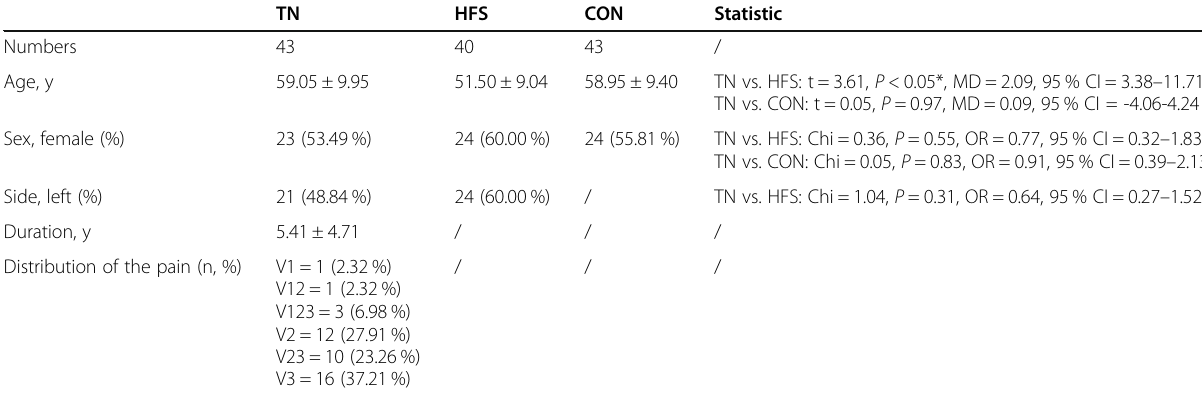
Table 1 Patient demographic information TN HFS CON